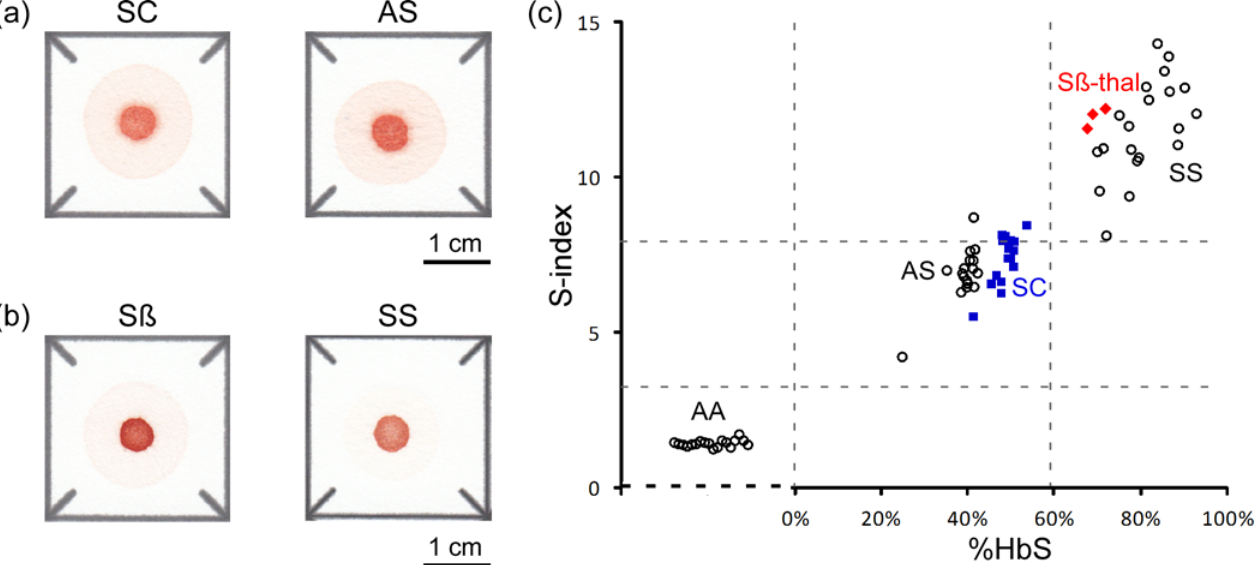
Fig 4. Diagnosis of other forms of sickle cell disease. ( a ) Representative images of blood stains produced in paper by HbSC samples and by HbAS samples, for comparison. ( b ) Representative images of blood stains produced in paper by HbS β + -thalassemia samples and by HbSS samples, for comparison. ( c ) Classification of HbSC and HbS β + -thalassemia samples in the S-index domain. The values of the S-index for ( (cid:1) ) HbAA, HbAS and HbSS samples (n = 55), ( ■ ) HbSC (n = 16) and ( ♦ ) HbS β + -thalassemia (n = 3) are shown on Y-axis. The location along the X-axis of each data point for HbAS, HbSS, HbSC and HbS β + -thalassemia samples corresponds to their %HbS measured with Hb electrophoresis by an off-site clinical laboratory. HbAA samples (n = 18) contained no HbS; hence the random lateral spread of the data points representing these samples on the plot.